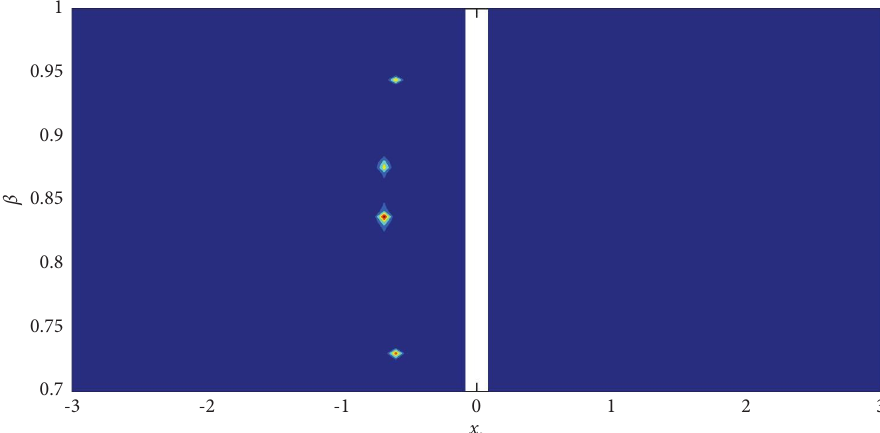
Figure 4: Convergence planes of second-order FNR on f